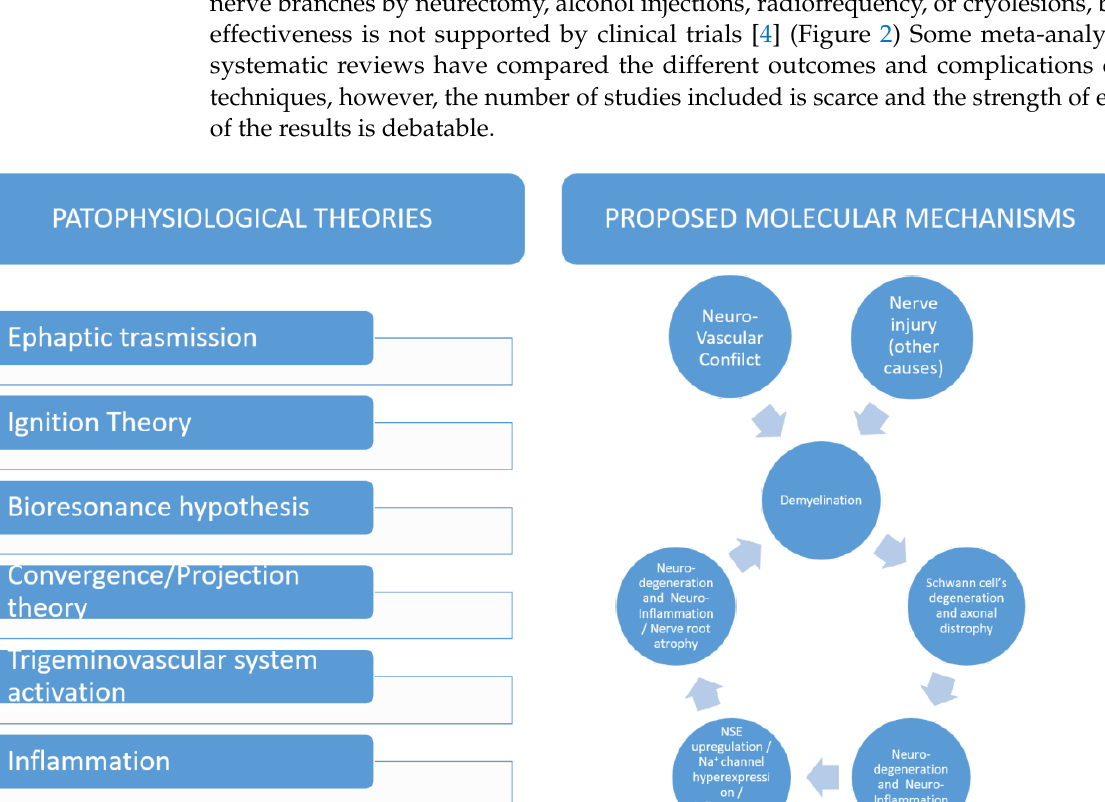
Figure 2. Summary of the available surgical procedures for the treatment of drug-resistant TN. 2. Materials and Methods 2.1. Enrollment Systematic reviews and systematic reviews with meta-analysis comparing different interventional techniques for the treatment of TN were collected through multiple data-